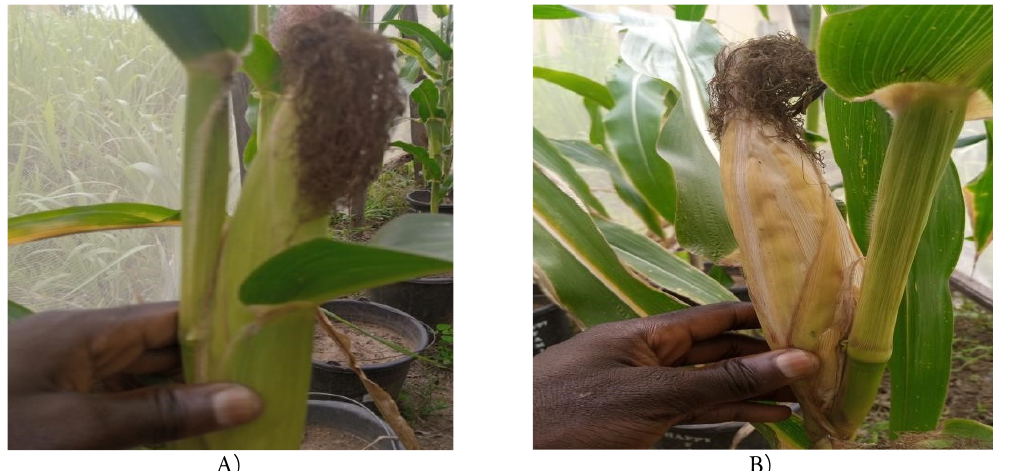
Figure 4. Popcorn with A) NMW at maturity and B) MTIW at maturity